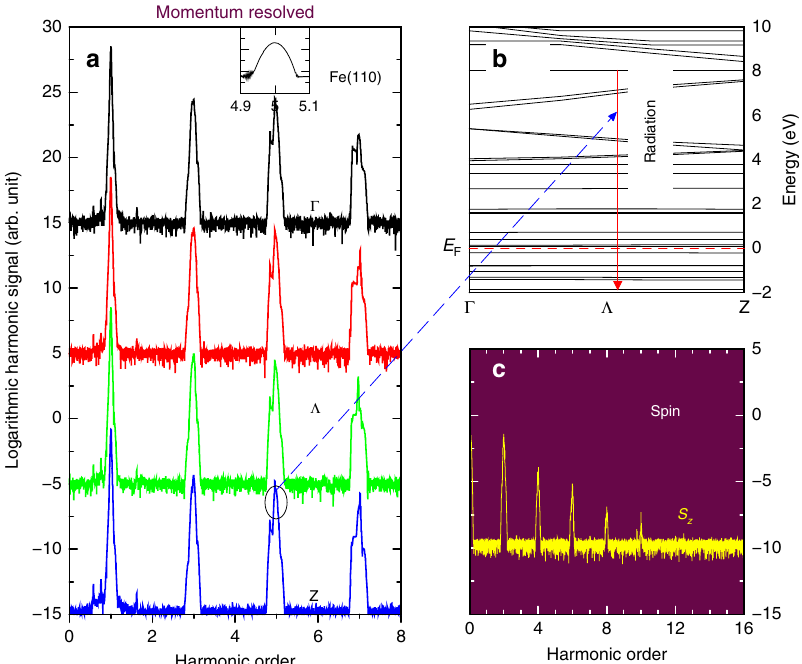
Fig. 4 Crystal-momentum-resolved high-harmonic generation and spin harmonic generation. a Crystal-momentum-resolved harmonic signal from the Z to Γ point on a logarithmic scale. The laser is linearly polarized along the y axis, and the signal is from the x axis. Except the one at Z , all the curves are shifted vertically. Top inset: Zoomed-in view of the 5th harmonic at a different k point. b Band dispersion along the Γ – Z direction for the Fe(110) monolayer. The 5th harmonic corresponds to several crucial transitions from conduction states between 8 and 9.36 eV above the Fermi level (see the horizontal dashed line) to a state at − 1.87 eV below the Fermi level. The arrow denotes this radiation. c Spin harmonic generation spectrum. Its zeroth order denotes the demagnetization, while higher orders represent the oscillation. The harmonic only appears at even orders, due to SU(2). The laser fi eld has to interact with the system an even number of times to affect spins. These signals are normally weaker than the emission from the electric Fig. 4a. Note that in our calculation all Γ and Z points are approximate since we have to shift the k mesh slightly in order to get better convergence. For clarity, in Fig. 4a we vertically shift all the curves except the bottom one. These spectra carry rich information about the band states. We see that harmonics at different orders change with k differently and this change is not limited to the lower-order harmonics. Higher-order harmonics show an even stronger dispersion. We take the fi fth harmonic as an example. We see there are many smaller peaks. These peaks do not distribute symmetrically around the nominal 5th order. This is an important indication that the harmonic engages real tran- sitions among band states 10 , where the harmonic carries the band structure information and thus allows one to crystal-momentum